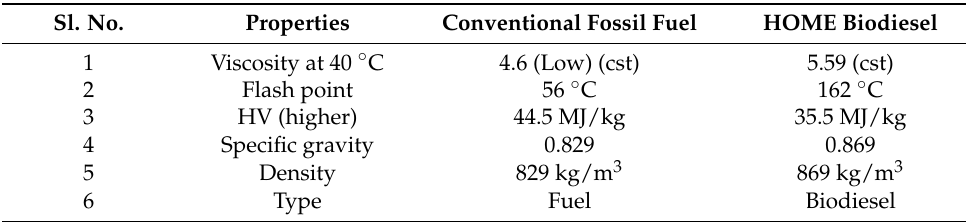
Table 1. Properties of liquid fuels [20]. Sl. No.